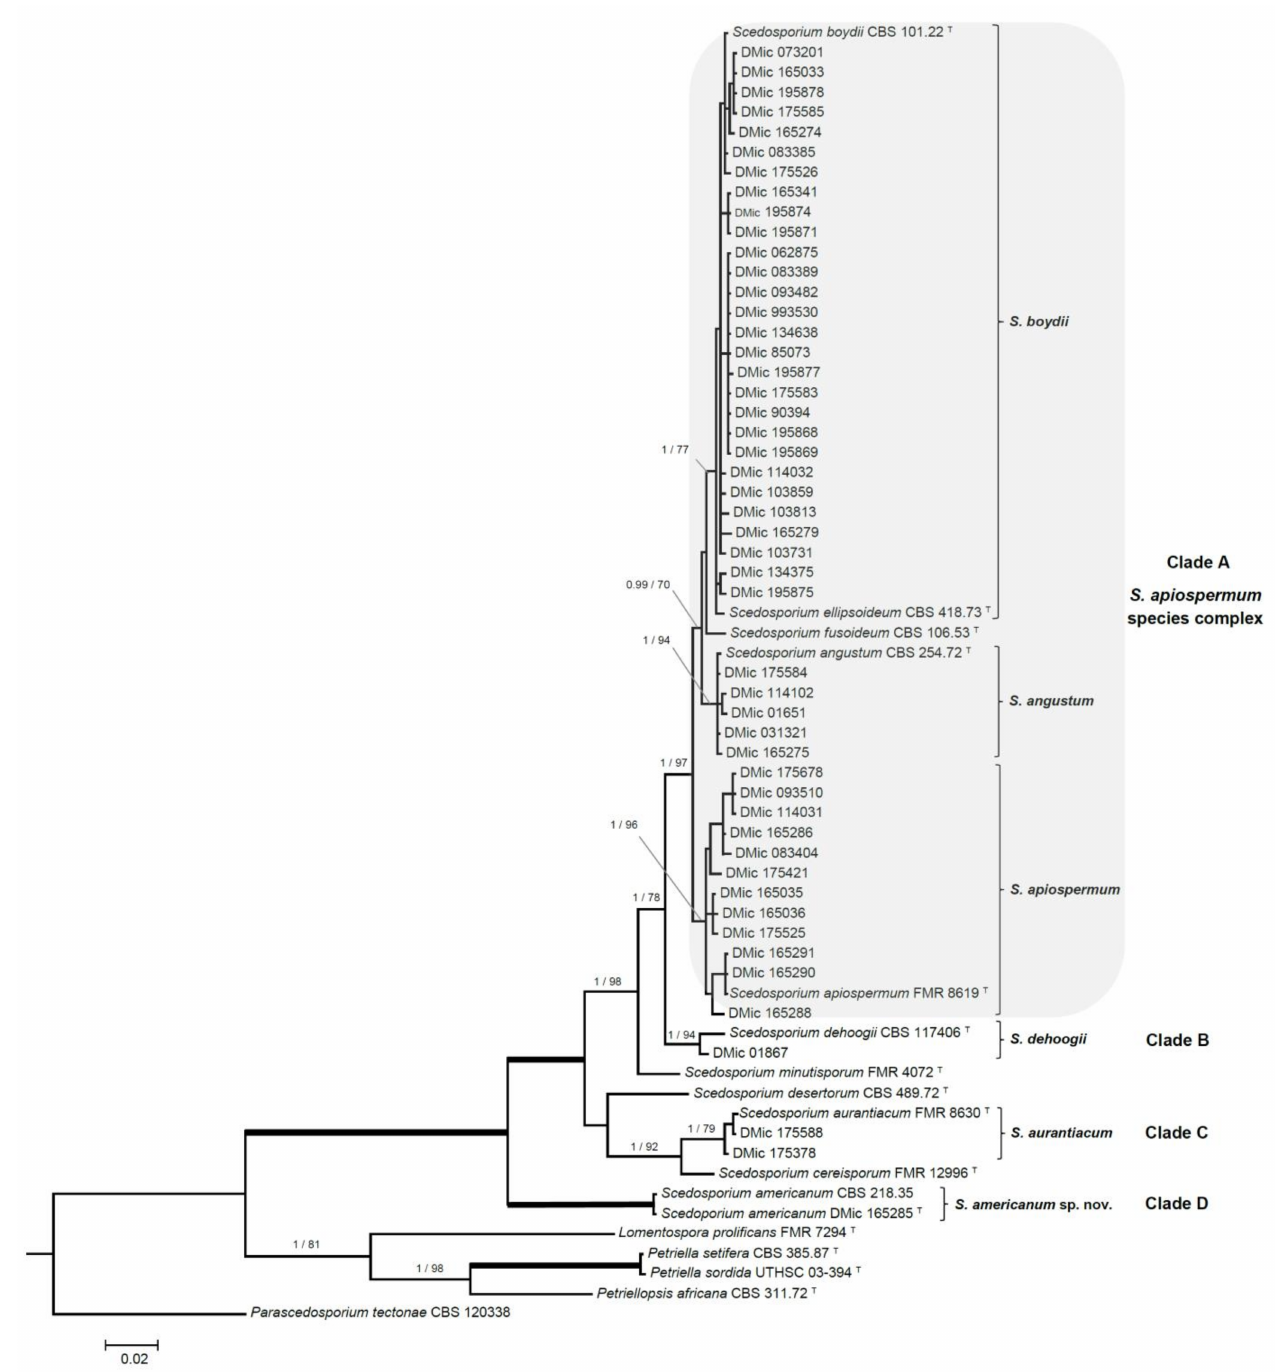
Figure 1. Bayesian phylogenetic tree built using DNA sequences from two loci (ITS and BT 2). Bayesian posterior probability values over 0.95 and bootstrap support scores over 70 % are indicated on the nodes. Branches in bold represent 1/100 values. Parascedosporium tectonae was selected as outgroup. T = ex-type strain. Alignment length 989 bp. The sequences not generated by us were retrieved from